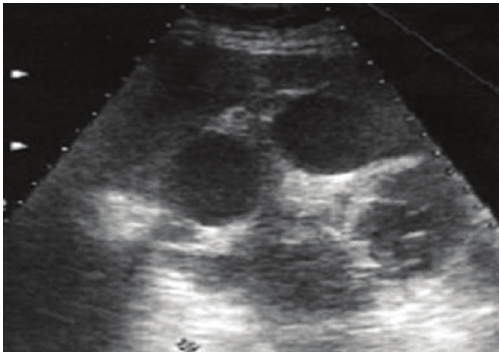
Figure 1: Ultrasonography revealed a multivesicular cystic mass of 12 × 11cm, in the location of splenic hilus.